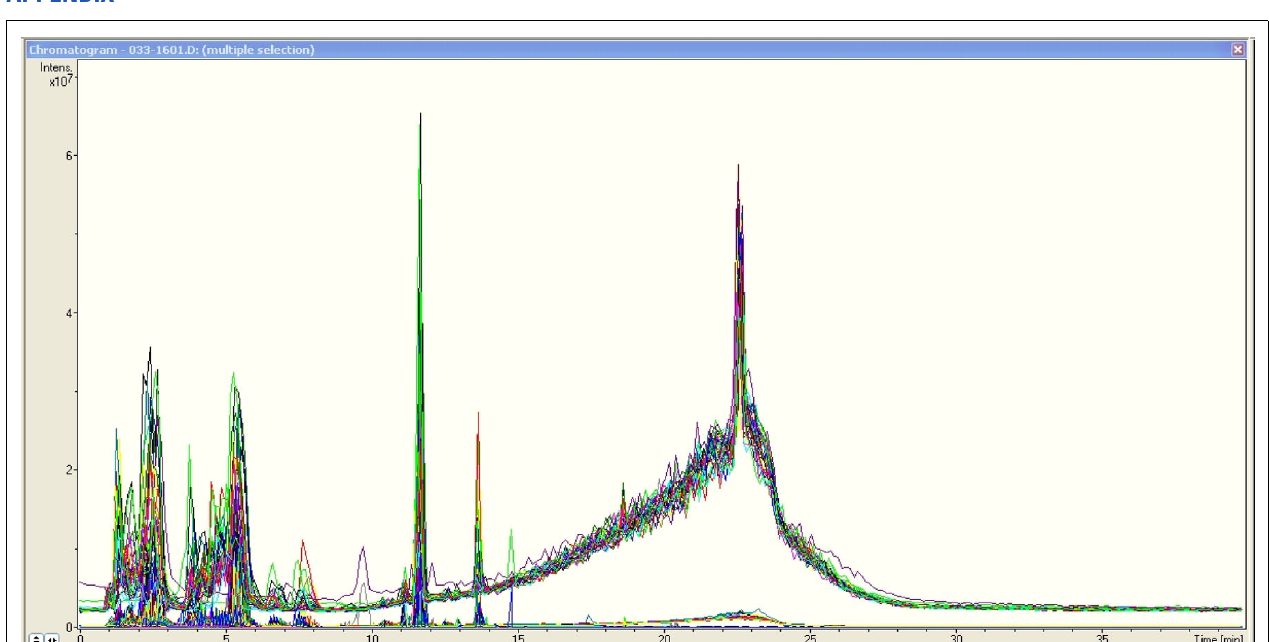
FIGUREA1 | RP-HPLC-ESI-MS total ion chromatograms of all 32 sap samples from plant setA.